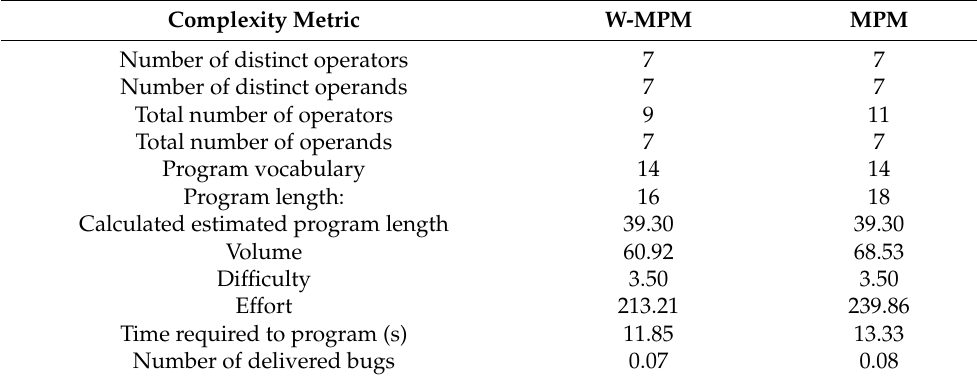
Table 4. Halstead complexity analysis for W-MPM and